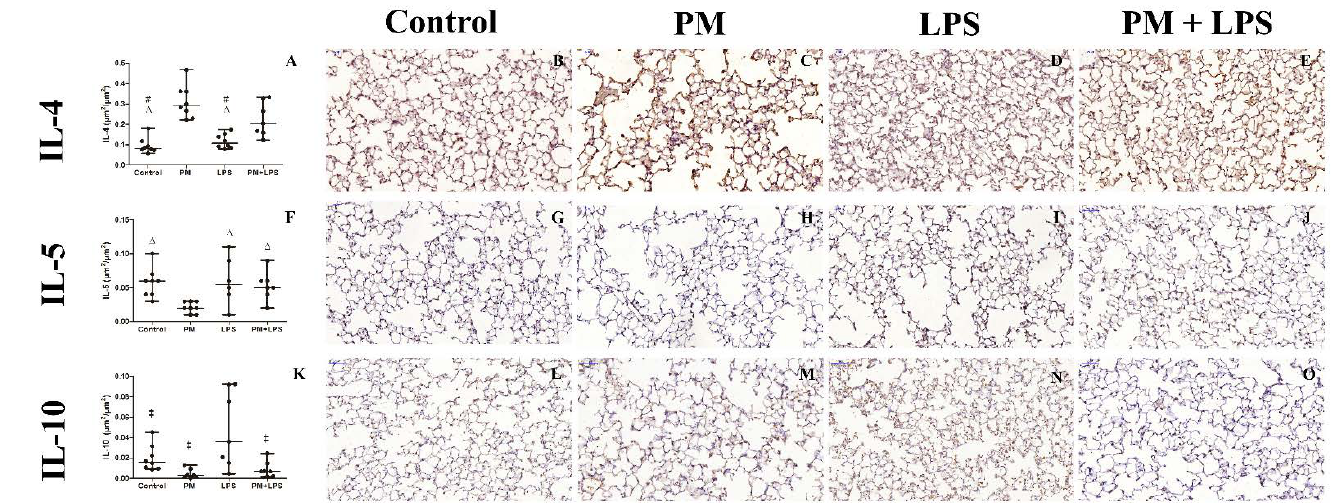
Figure 5. Graphical representation of IL-4, IL-5, and IL-10 assessment in the lung parenchyma and representative photomicrographs of immunostained lung tissue. ( A ) Graphical representation of IL-4 in the lung parenchyma. Representative photomicrographs of the lung parenchyma immunostained with anti-IL-4 antibody: ( B ) control group, ( C ) PM group, ( D ) LPS group, and ( E ) PM+LPS group. Positive stains for IL-4 are mostly in the epithelial cells. ( F ) Graphical representation of IL-5 in the lung parenchyma. Representative photomicrographs of the lung parenchyma immunostained with anti-IL-5 antibody: ( G ) control group, ( H ) PM group, ( I ) LPS group, and ( J ) PM+LPS group. Positive stains for IL-5 are mostly in the epithelial cells. ( K ) Graphical representation of IL-10 in the lung parenchyma. Representative photomicrographs of the lung parenchyma immunostained with anti-IL-10 antibody: ( L ) control group, ( M ) PM group, ( N ) LPS group, and ( O ) PM+LPS group. In the LPS group, positive stains for IL-10 are mostly in the inflammatory cells. Each point of the graph represents one animal and bars show the median. ‡ p < 0.05 compared to the LPS group. ∆ p < 0.05 compared to the PM group. # p < 0.05 compared to the PM+LPS group. Scale bars = 50 µ